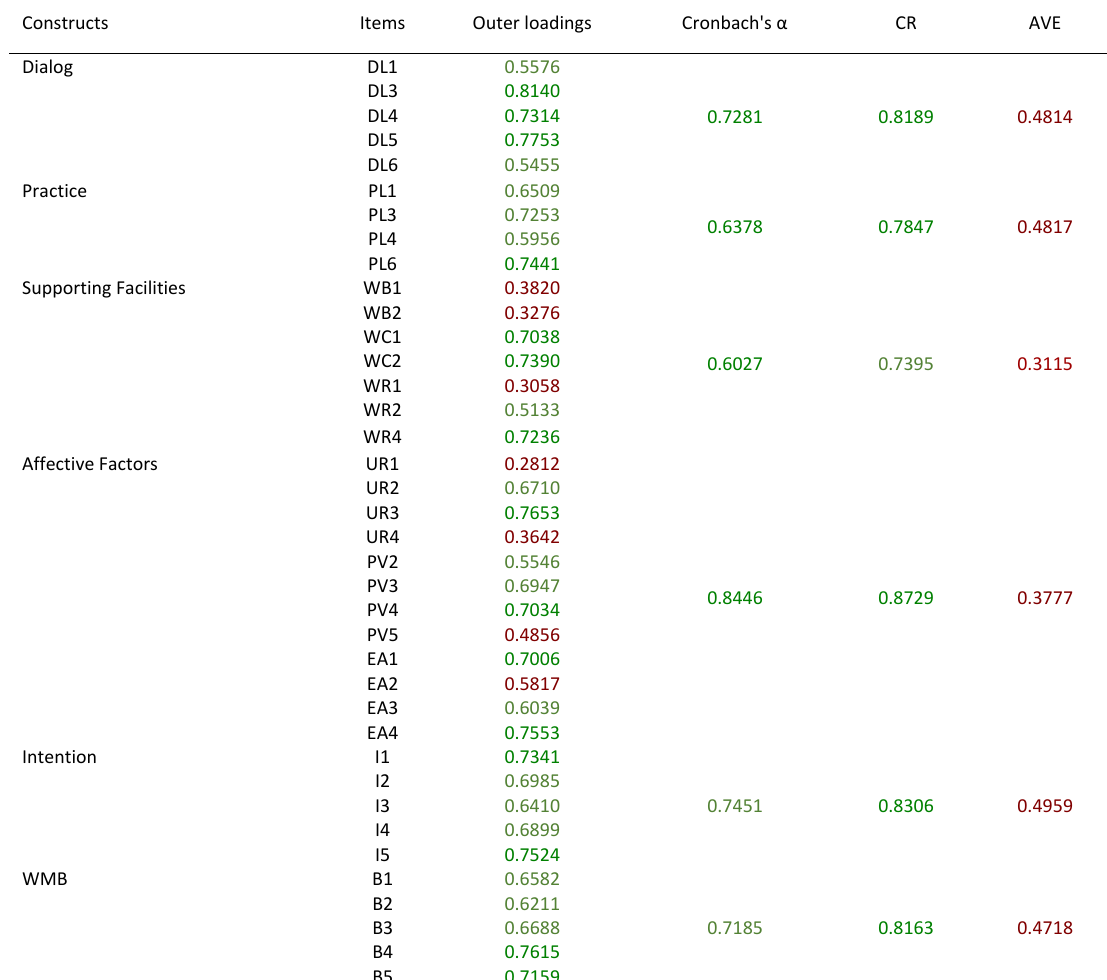
Table 4. The reliability and convergent validity of improved model with deleted items